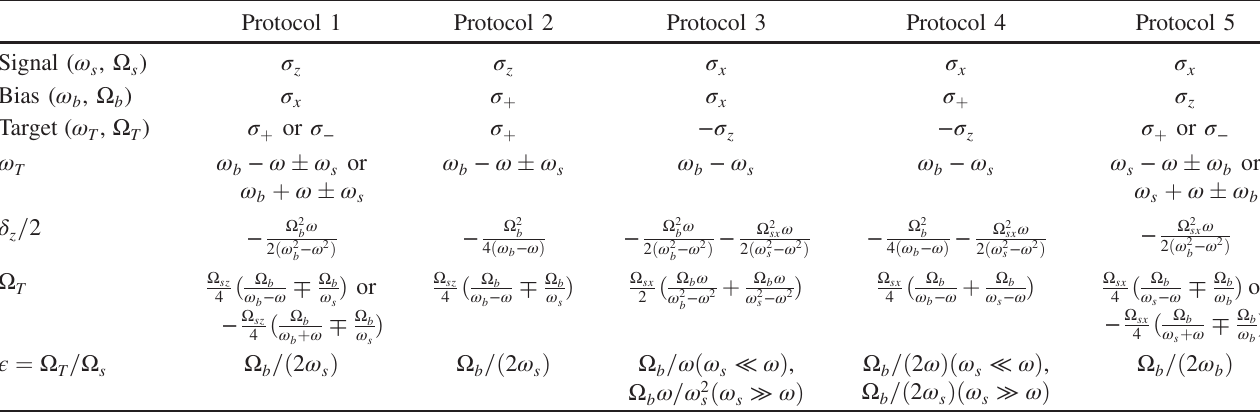
TABLE I. Various quantum-sensing protocols based on quantum frequency mixing. All parameters are expressed in the rotating frame defined by e − i ð ω t= 2 Þ σ z except for the signal and bias Hamiltonians, which are in the lab frame. The Bloch-Siegert shift Ω 2 = ð 8 ω Þ and possible frequency mixing due to the spin-locking driving field in the Rabi measurement are neglected. In the notation of the polarization of the signal, the bias, and the target (mixed) signal, σ denotes a circularly polarized field with the form (cid:2) Ω ½ cos ð ω t Þ σ ω t Þ σ σ Ω cos ð ω t Þ σ x (cid:2) sin ð y (cid:4) , and z;x denote linearly polarized longitudinal and transverse fields with the form z;x . We note that all frequency mixing terms potentially of use for quantum sensing are listed for completeness, and terms not satisfying the near- resonance condition in Eq. (5) are neglected in practical calculations. Detailed derivations are included in Appendix